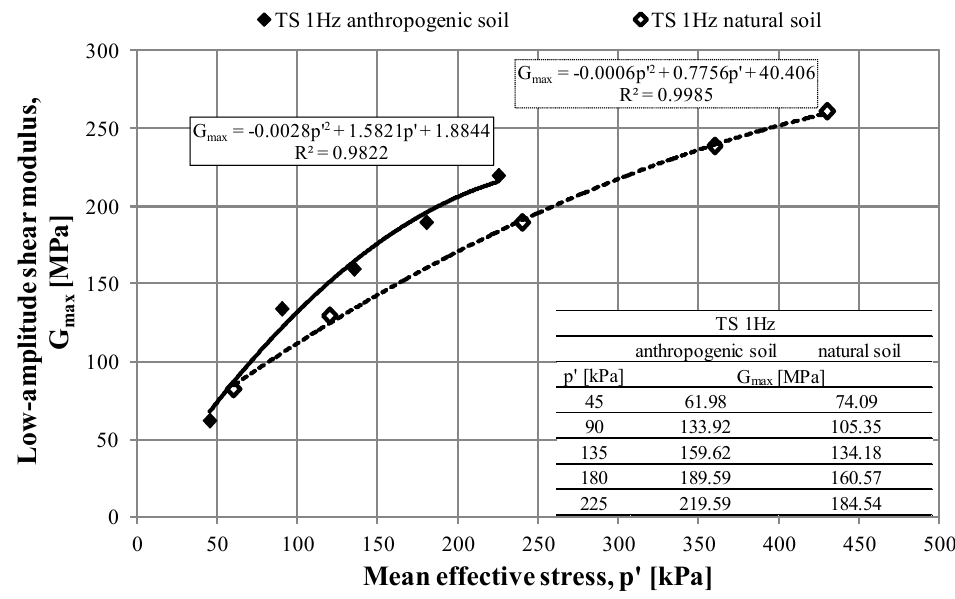
Fig. 11. Comparison of low-amplitude shear modulus of anthropogenic soil tested with natural soil from Sas et al. [14]